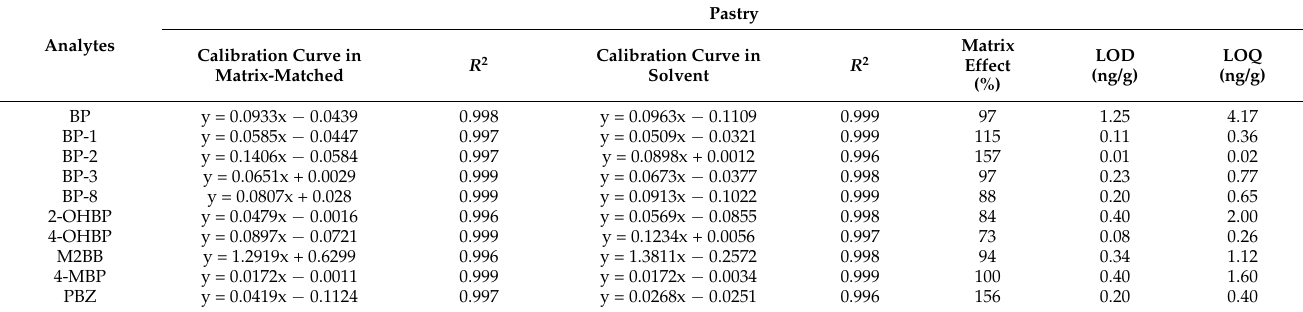
Table 2. Detection characteristics, linear range, matrix effect, limits of detection, and quantitation of target analytes in